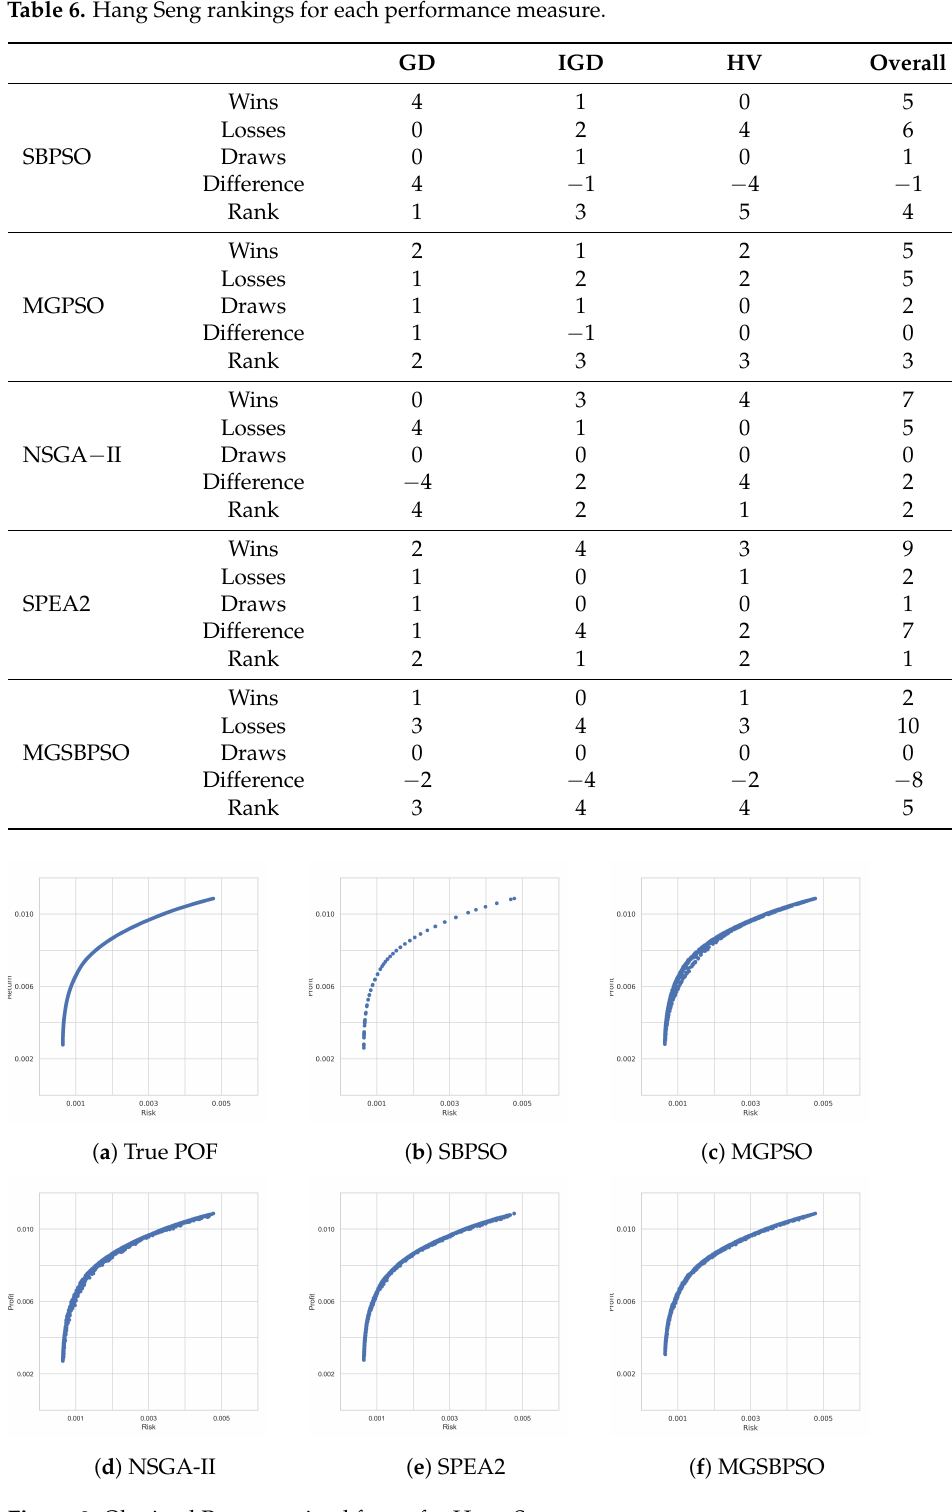
Figure 3. Obtained Pareto-optimal fronts for Hang